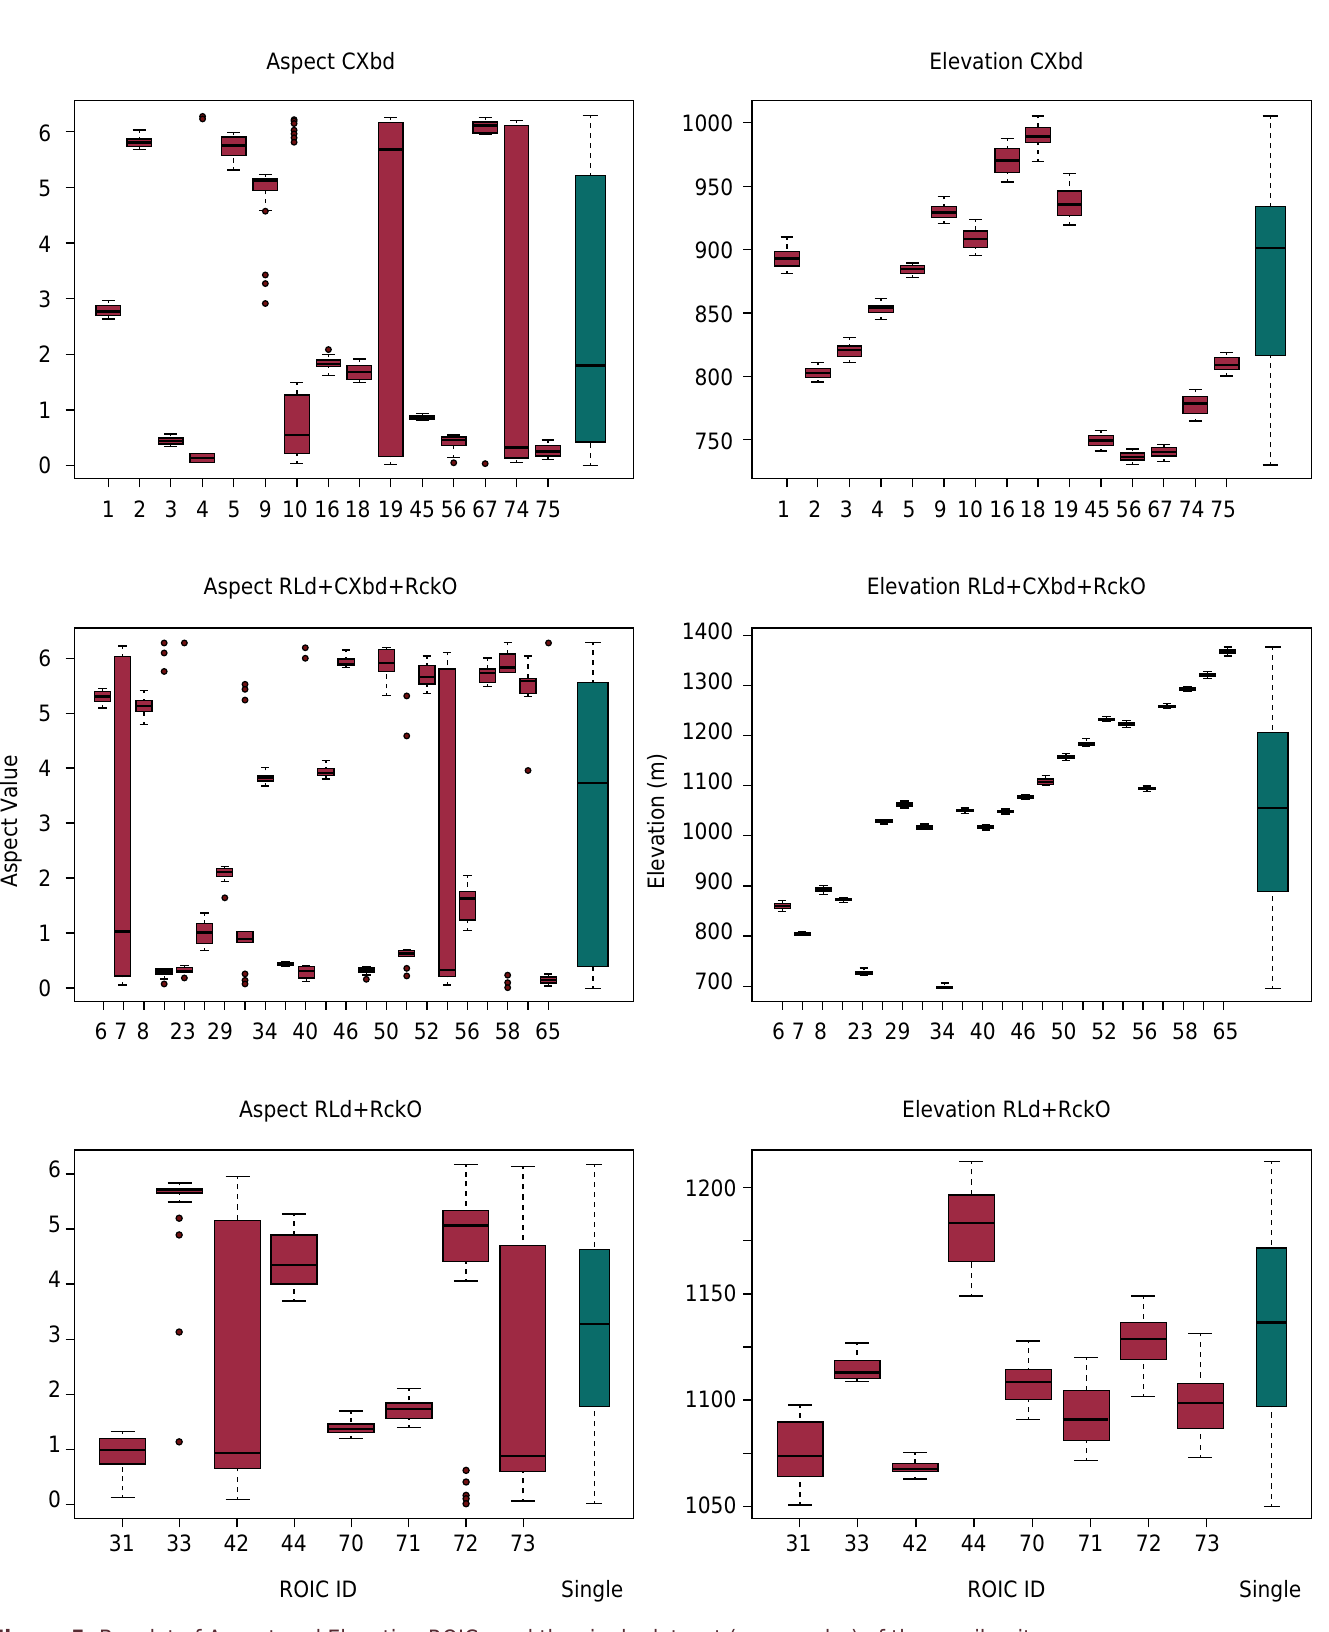
Figure 5. Boxplot of Aspect and Elevation ROICs and the single dataset (green color) of three soil